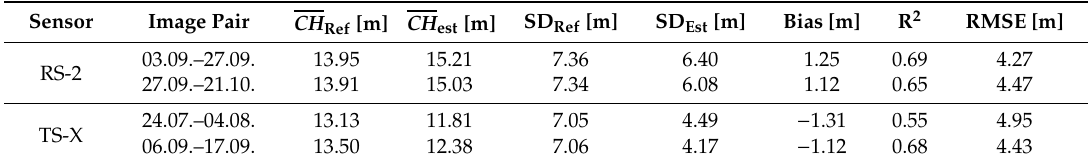
Table 4. Validation statistics of canopy heights per interferogram based on drone data. ( CH Ref = mean of the reference canopy height, CH Est = mean of the estimated canopy height, SD = standard deviation, RMSE = root mean square